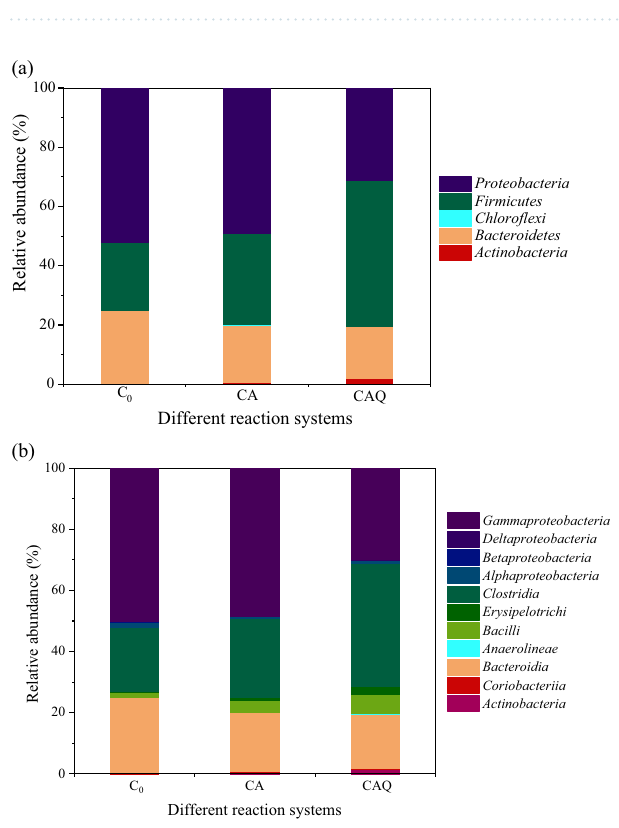
Table 1. EPS and DHA analysis in reaction systems during 2-CA degradation.